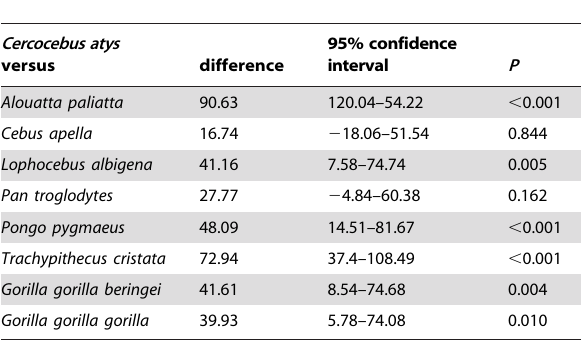
Table 3. Tests of Comparative Microwear Complexity ( Asfc ).